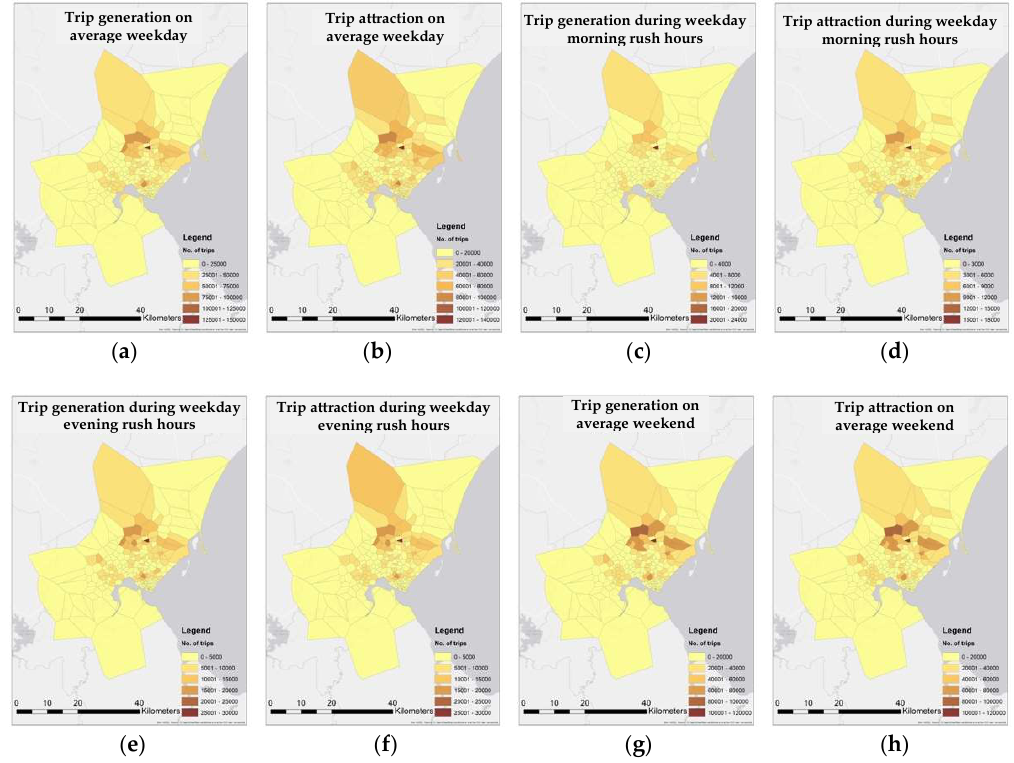
Figure 13. Trip generation and attraction maps: ( a ) trip generation on average weekday; ( b ) trip attraction on average weekday; ( c ) trip generation during weekday morning rush hours; ( d ) trip attraction during weekday morning rush hours; ( e ) trip generation during weekday evening rush hours; ( f ) trip attraction during weekday evening rush hours; ( g ) trip generation on average weekend; and ( h ) trip attraction on average weekend.